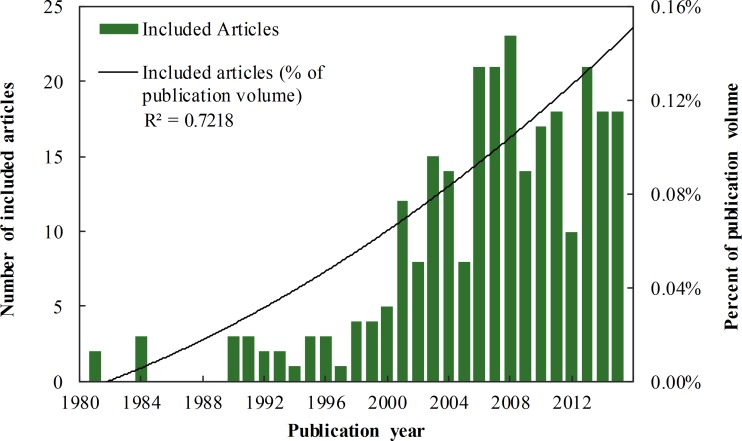
Published articles on the effects of non-consumptive recreation on animals by publication year.The numbers of articles are shown as raw numbers (shaded bars) and as percentages of the overall publication volume in the journal set used in this review (trendline; a second order polynomial function).